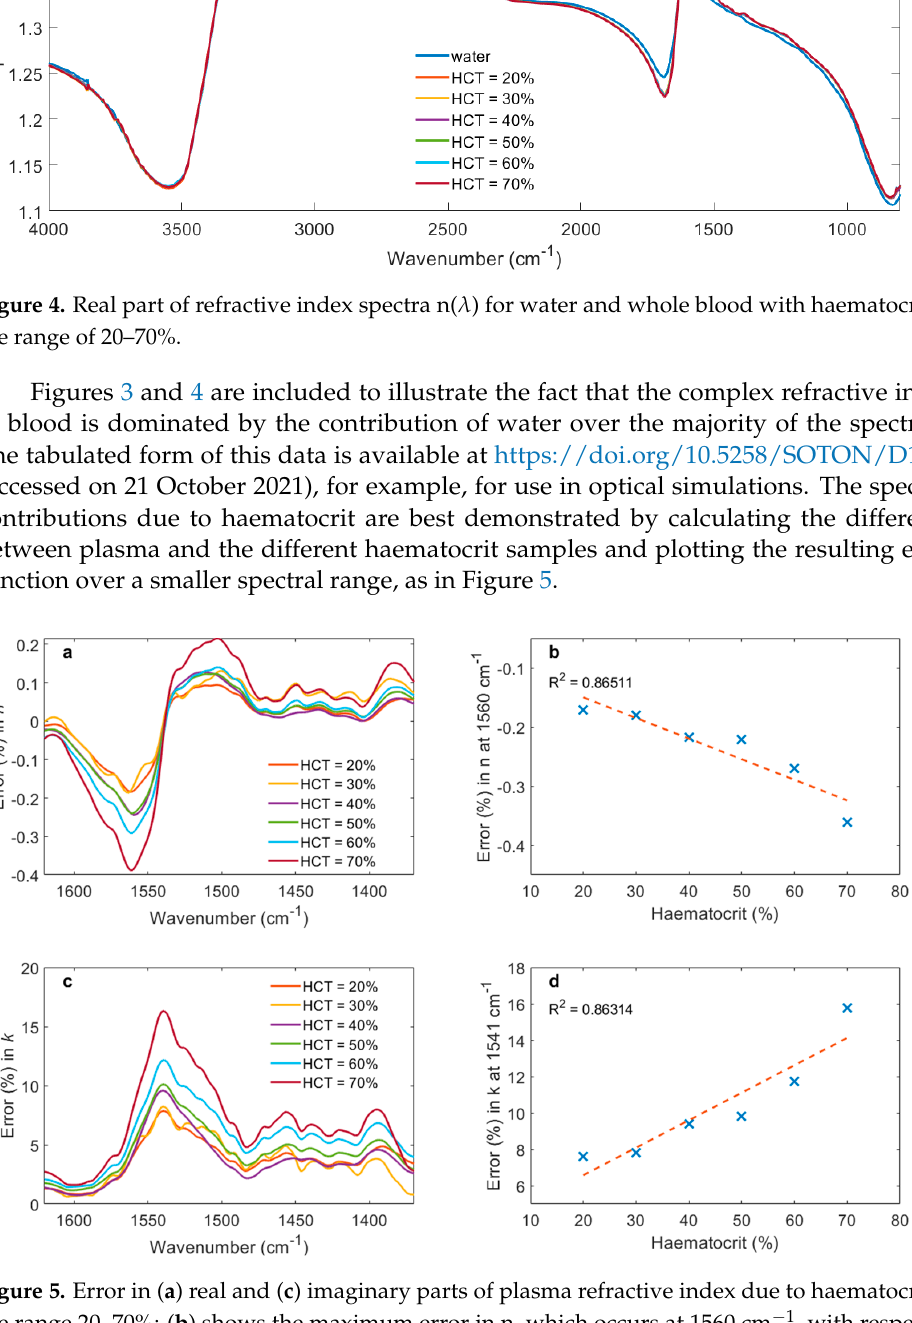
Figure 3. Imaginary part of refractive index spectra k( λ ) for water and whole blood with haematocrit in the range of 20–70%.